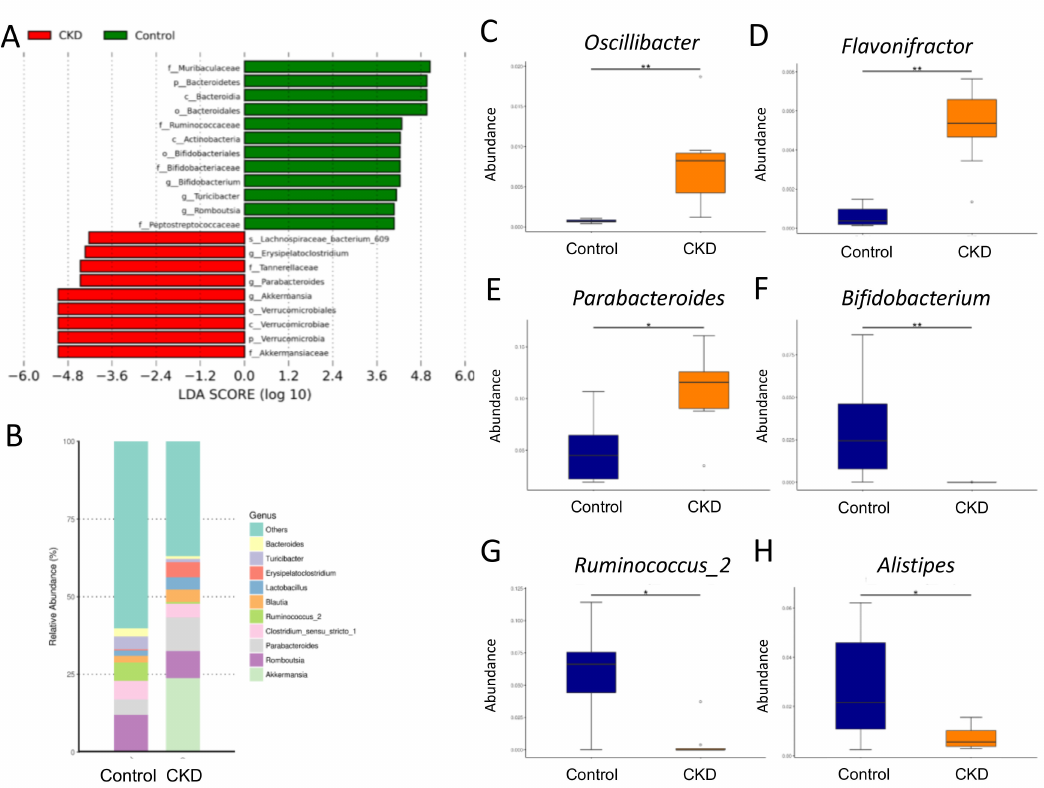
Figure 4. Gut microbiota at the genus level in mother rats. ( A ) The linear discriminant analysis e ff ect size (LEfSe) to identify the taxa that were significantly di ff erent between the two groups. ( B ) The relative abundance of top 10 genera of the gut microbiota between the two groups. The abundance of genera ( C ) Oscillibacter , ( D ) Flavonifractor , ( E ) Parabacteroides , ( F ) Bifidobacterium , ( G ) Ruminococcus_2 , and ( H ) Alistipes between the two groups. Control = female rats fed with regular chow; CKD = female rats fed with chow supplemented with 0.5% adenine for 3 weeks before pregnancy. Abundance = the number of bacterial operational taxonomic unit (OTU) sequences detected in each sample. Data are shown as means ± SD; n = 8 / group. The asterisk indicates p < 0.05 vs. control. The double asterisk indicates p < 0.01 vs.